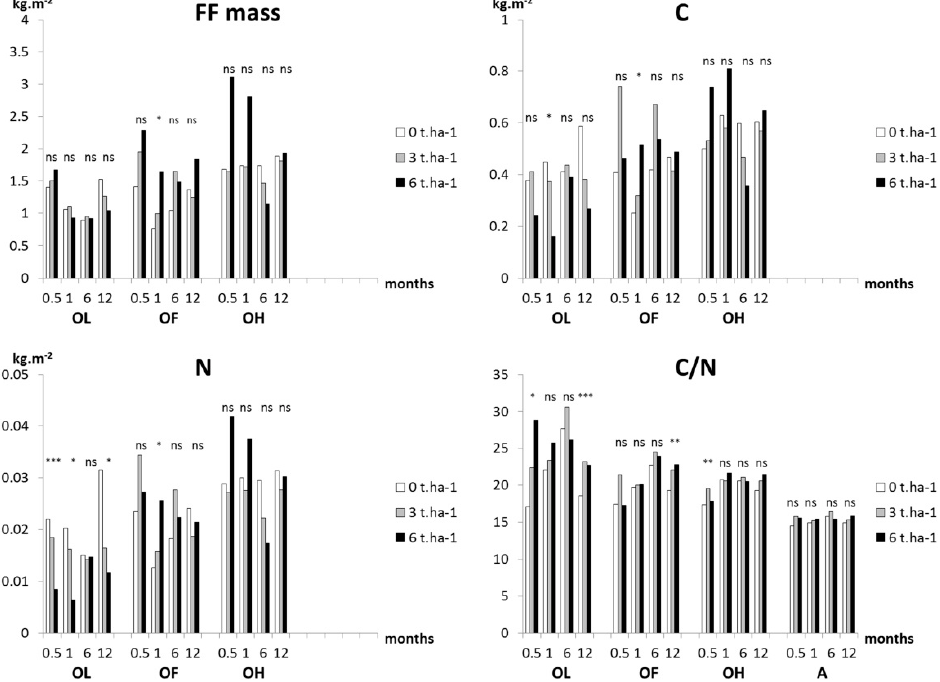
Figure 2. Comparisons of organic matter properties under different WA treatments. Significances of F -tests of one-way ANOVAs by horizons and sampling dates are shown (*** p < 0.001, ** p < 0.01, * p < 0.05, ns p ≥ 0.05). FF: Forest floor.